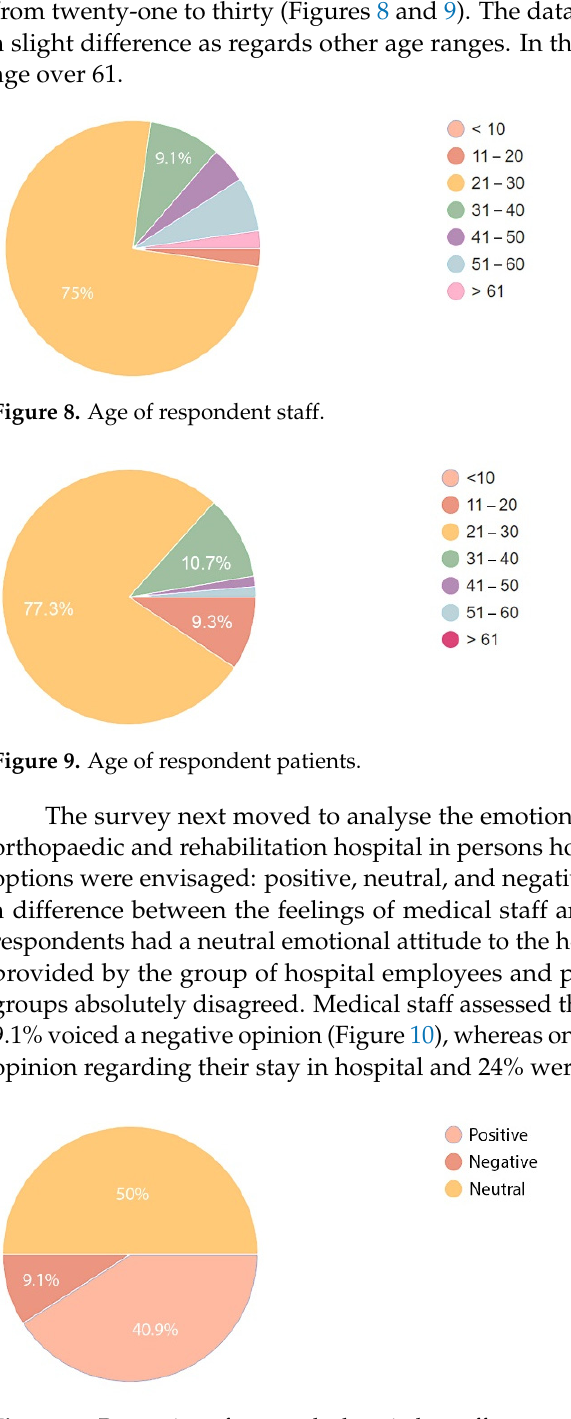
Figure 10. Perception of stay at the hospital—staff . Figure 11. Perception of stay at the hospital—patients. Figure 11. Perception of stay at the hospital—patients.